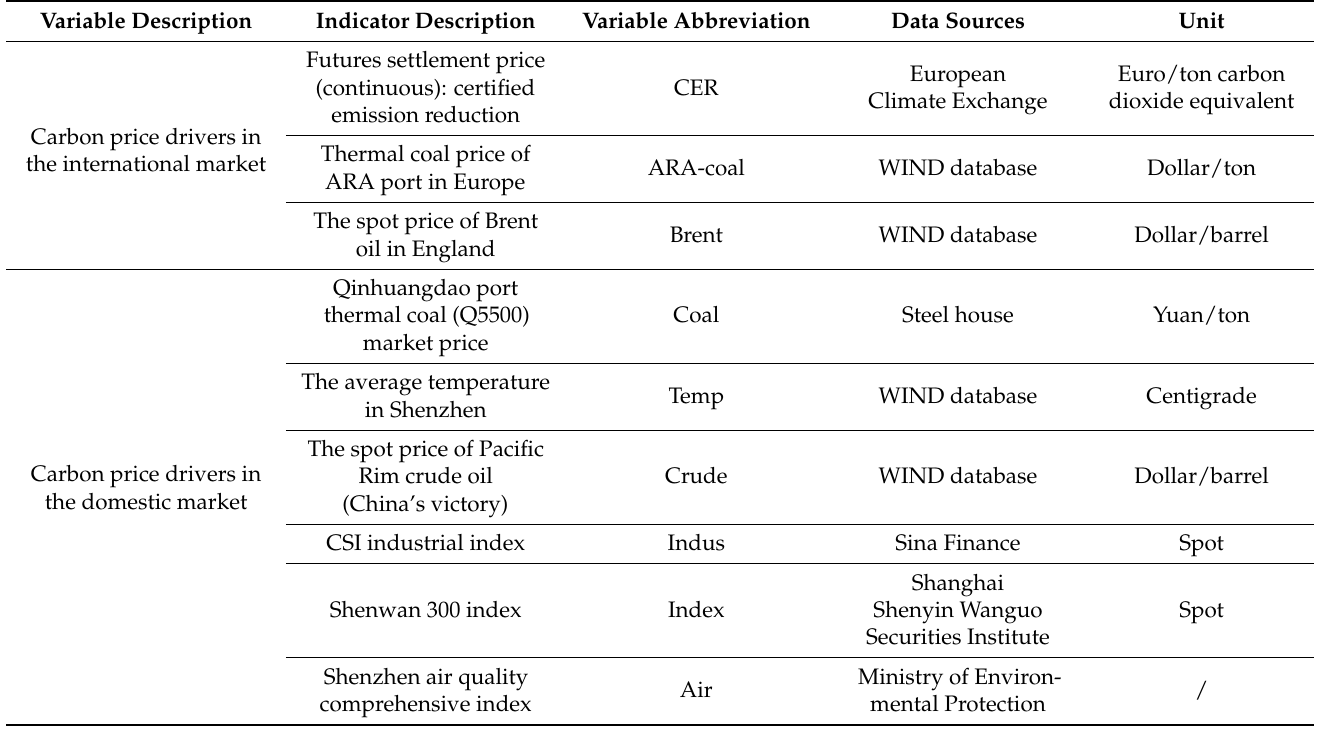
Table 2. Data sources and descriptions.